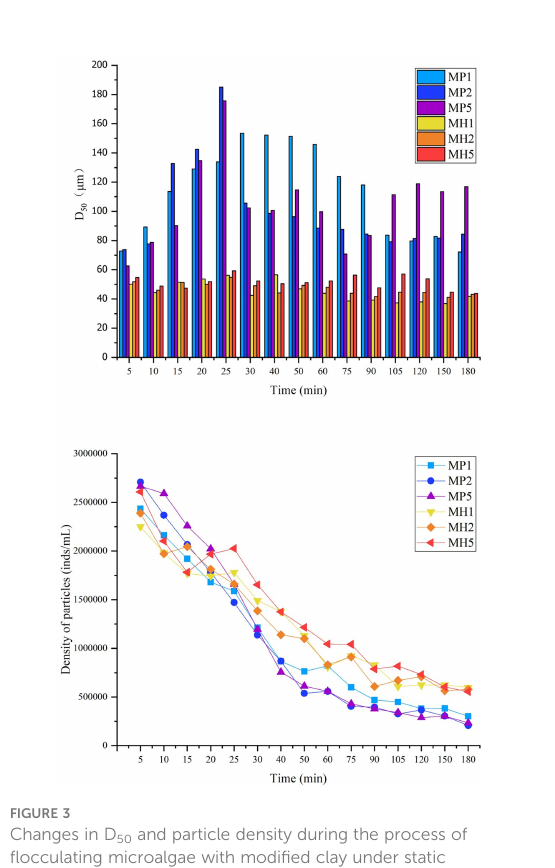
FIGURE 3 Changes in D 50 and particle density during the process of fl occulating microalgae with modi fi ed clay under static conditions.